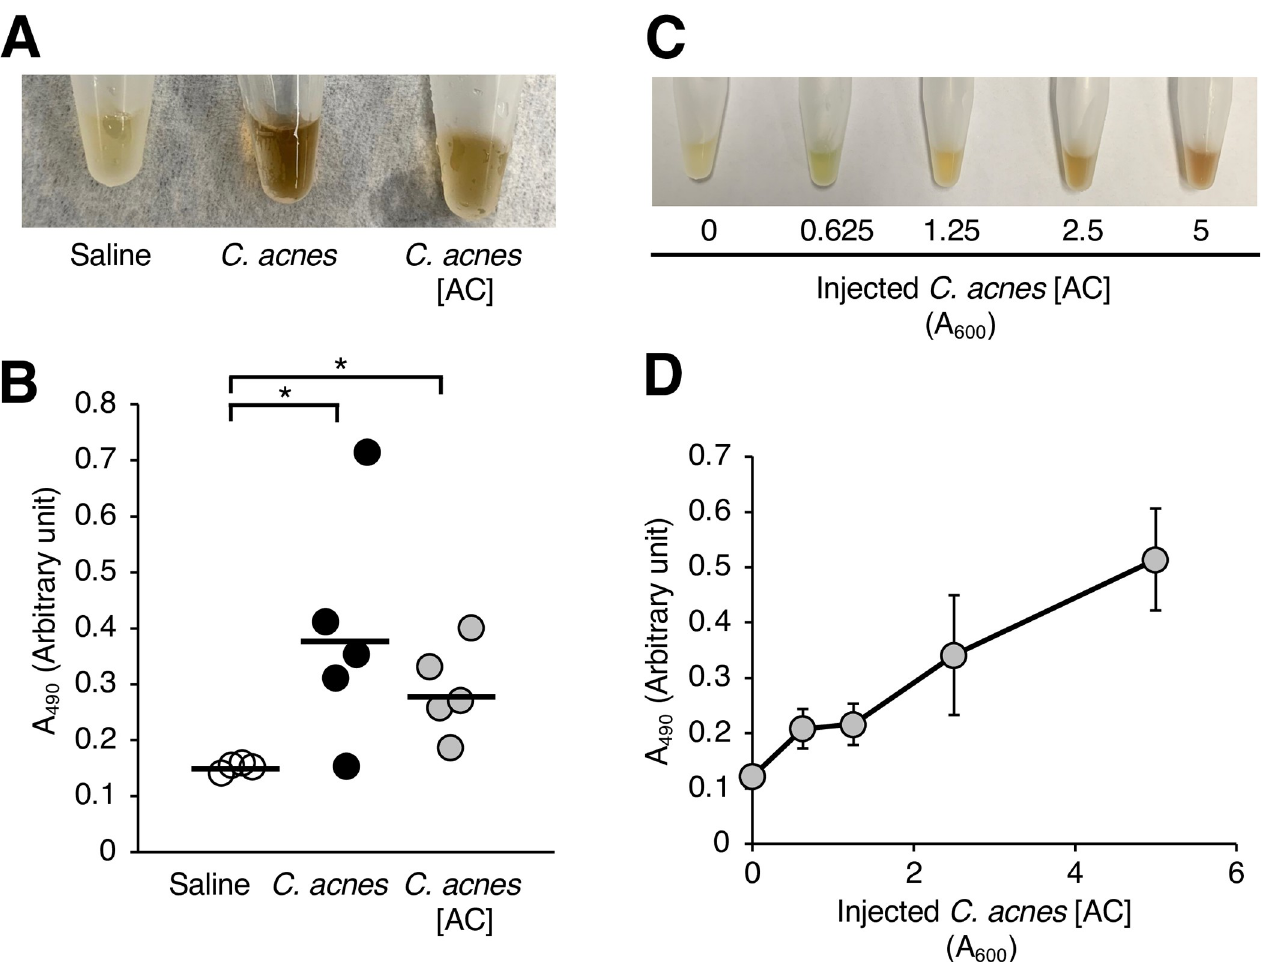
Fig 3. Melanization of silkworm hemolymph induced by injection of heat–killed C . acnes cells. ( A , B ) Silkworms were injected with saline (Saline), C . acnes cell suspension ( C . acnes ; 1.1 x 10 7 cells/larva), or the autoclaved C . acnes cell suspension ( C . acnes [AC]). After incubation for 3 h at 37˚C, the silkworm hemolymph was collected. Photographs of the silkworm hemolymph were taken ( A ) and absorbance at 490 nm (A 490 ) ( B ) was measured. n = 5/group. Statistically significant differences between groups were evaluated using the Tukey test. � P < 0.05. ( C , D ) Dose–dependent induction of silkworm hemolymph melanization by autoclaved C . acnes cell suspension ( C . acnes [AC]). Absorbance at 600 nm (A 600 ) of the autoclaved C . acnes cell suspension ( C . acnes [AC]) was measured. Silkworms were injected with 50 μ l of the autoclaved C . acnes cell suspension ( C . acnes [AC]; A 600 = 0.625–5). After incubation for 3 h at 37˚C, the silkworm hemolymph was collected. Photographs of the silkworm hemolymph were taken ( C ), and absorbance at 490 nm (A490) ( D ) was measured. The arbitrary unit was defined as the absorbance at 490 nm of a sample of silkworm hemolymph (50 μ l) mixed with saline (50 μ l).